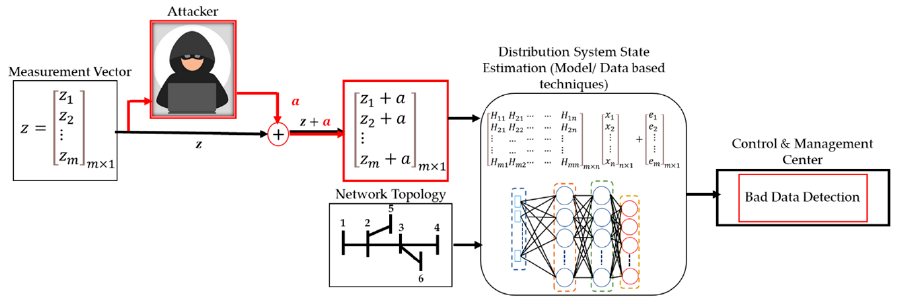
Figure 1. General Effect of FDIAs on Measurements and DSEE Procedure.